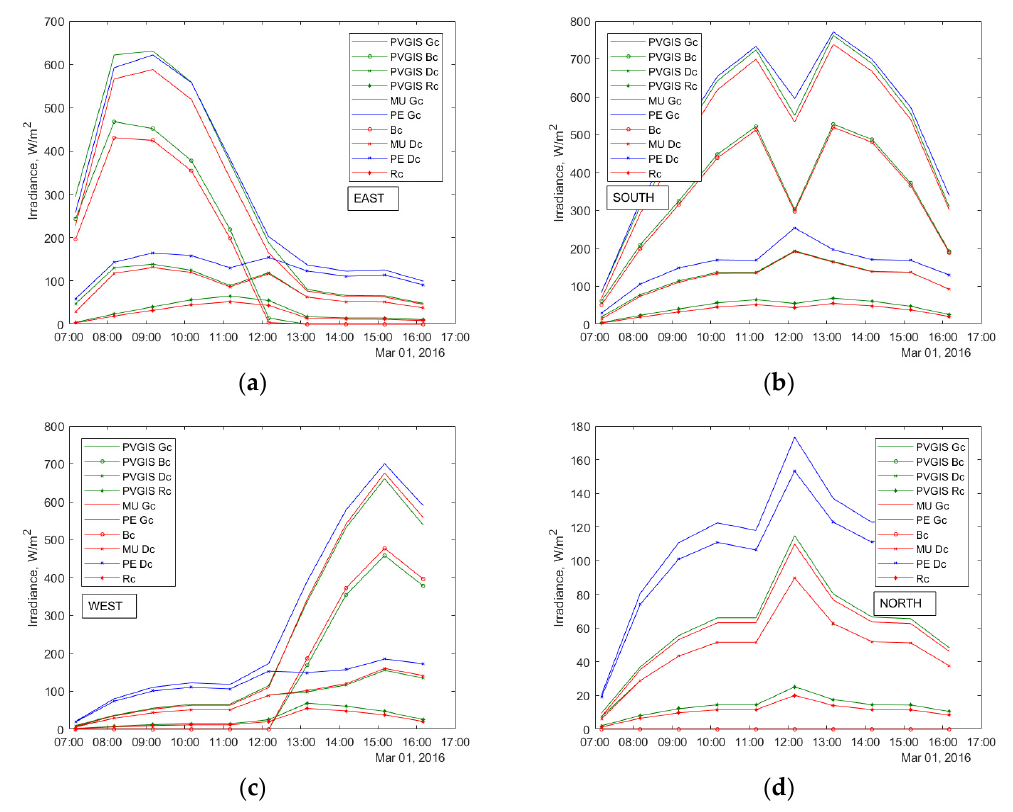
Figure 7. Comparison of global in-plane irradiance from PVGIS and models outcomes, as well as the beam, diffuse and reflected components for a random day in Murcia, Spain. ( a ) East, ( b ) south, ( c ) west and ( d ) north orientations (GMT + 0).